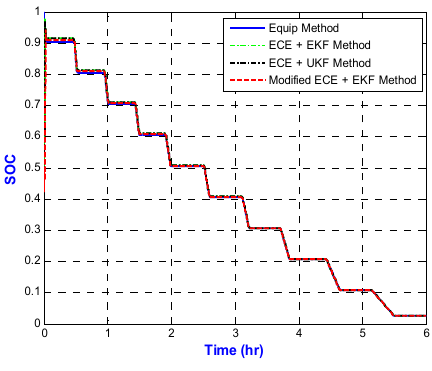
Figure 14. SOC estimation under discharge in Experiment II.